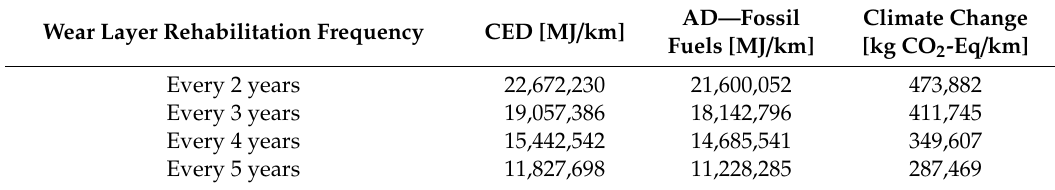
Table 15. The impacts of an e-road construction and maintenance with the different wear layer rehabilitation frequencies.